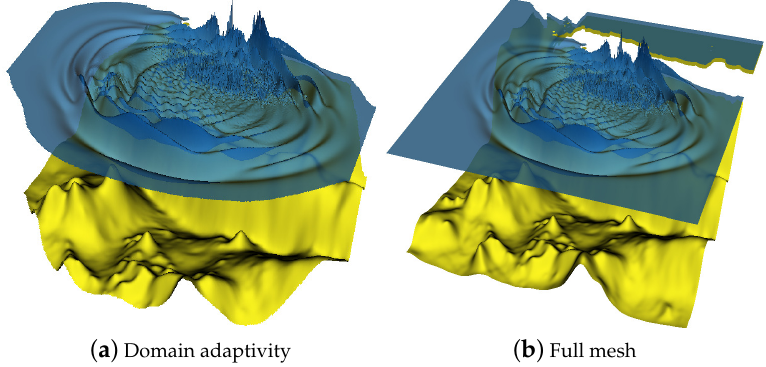
Figure 21. Active generation: comparison between the bottom and the free surface elevation at t = 1500 s between the domain adaptivity method and the full mesh.